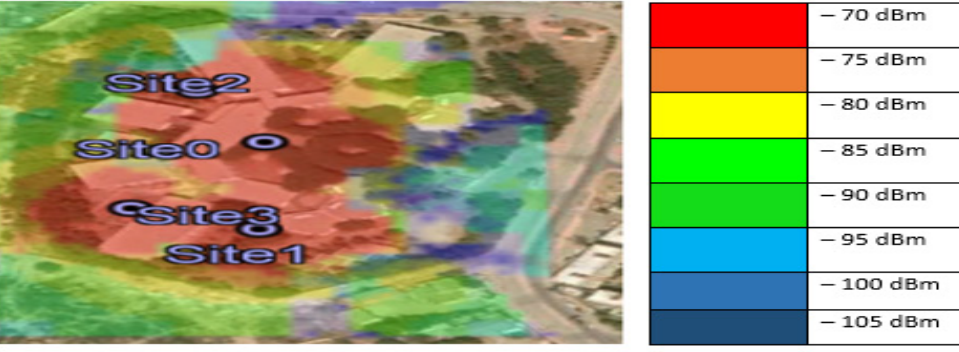
Figure A4. Prediction of power level coverage in ENST campus with four base stations.